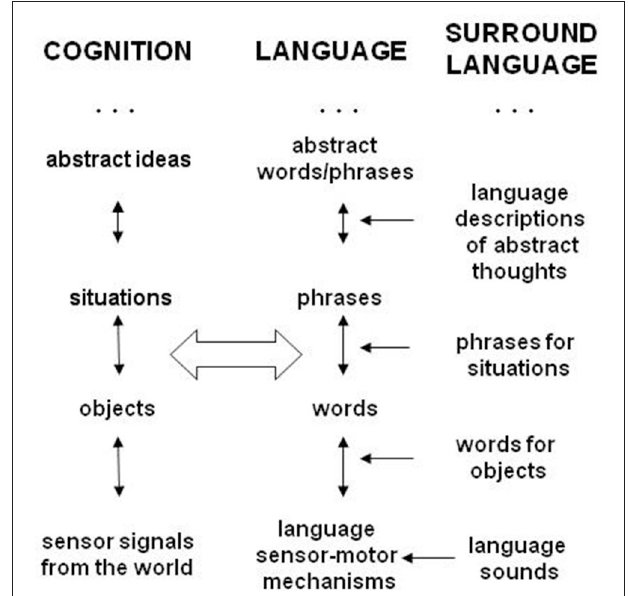
representation has two parts, cognitive and language. Learning language is grounded in the surrounding language throughout the hierarchy. Cognitive hierarchy is grounded in experience only at the very “bottom”; the cognitive hierarchy is constructed from experience guided by language.